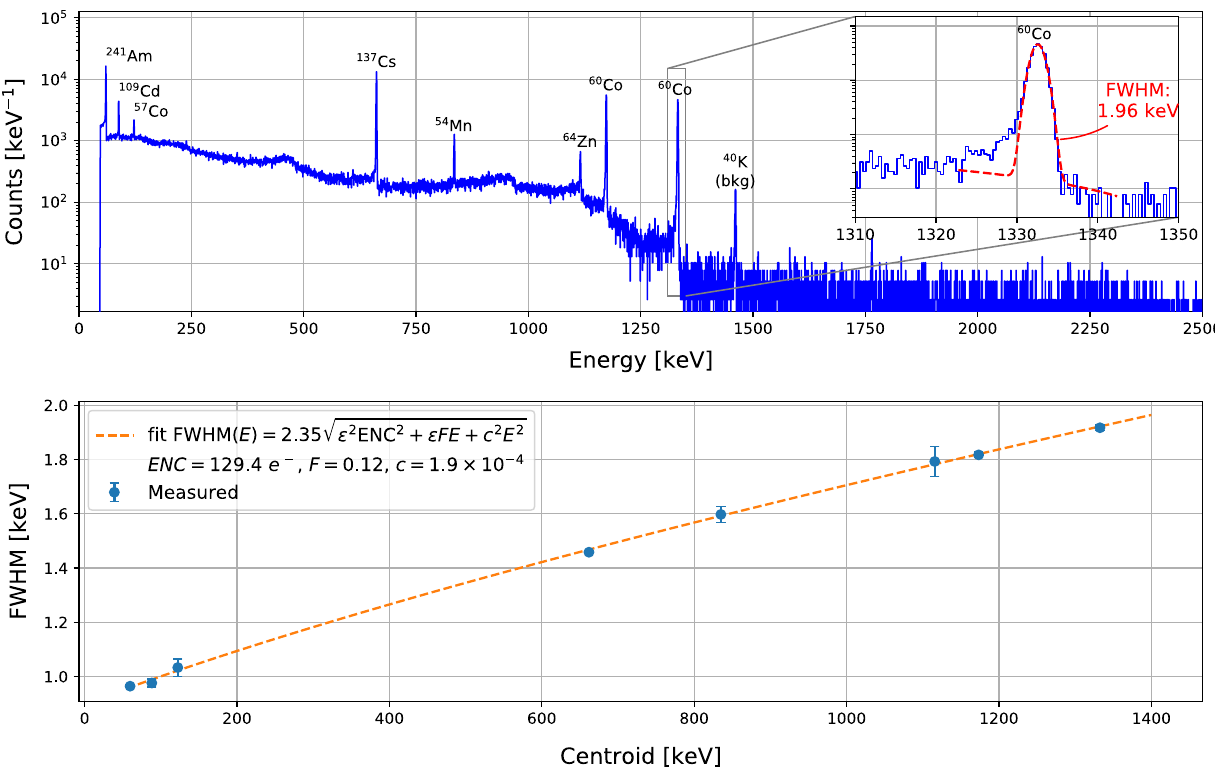
Fig. 5 Upper panel: Energy spectrum obtained by irradiating the pro- totype detector by a multi-isotope calibration source. Lower panel: FWHM as a function of the energy. A fit of the formula to data shown Fig. 6 2D histogram showing the classified 228 Th events distribution. Vertical axis corresponds to the classifier value (output of the neural network) and the horizontal one to the reconstructed energy. The bottom panel shows the corresponding energy spectra (before and after the cut). The cut value is represented by the dashed horizontal line (ANN = 0.52)